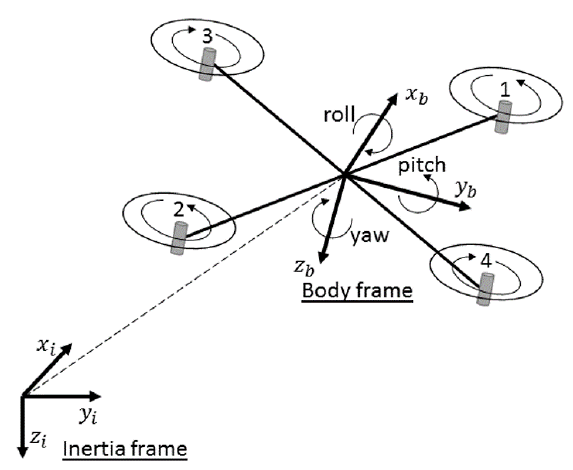
Figure 1. Reference coordinate system of the